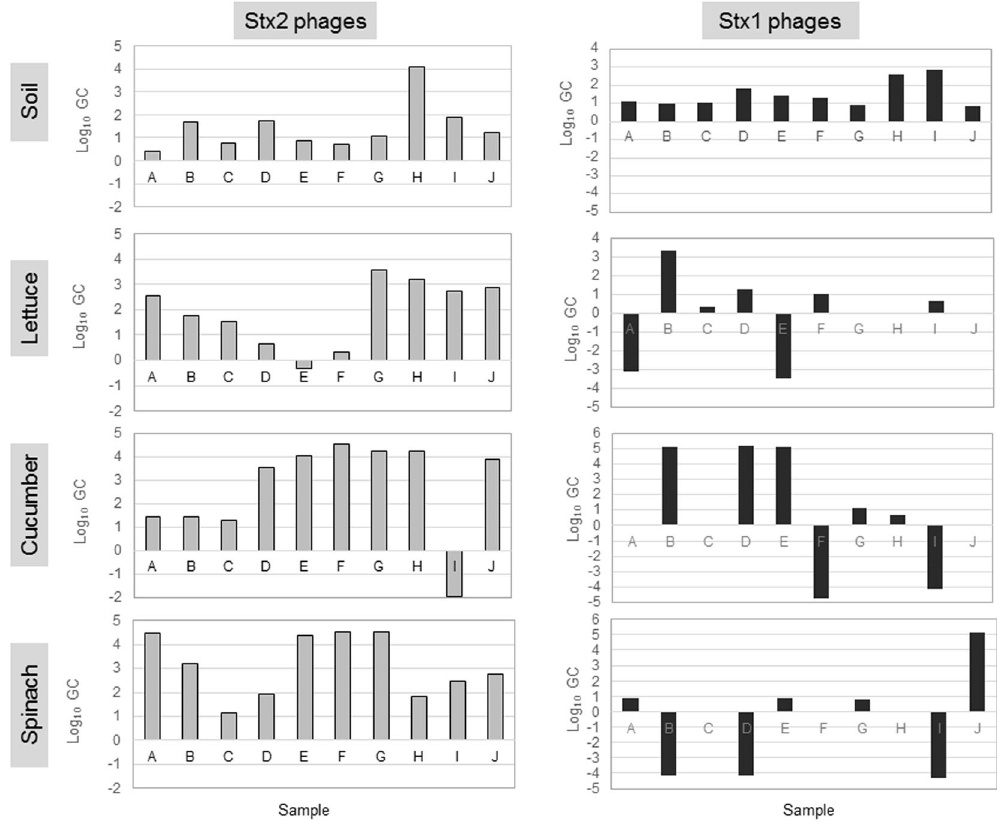
Figure 1. Difference in log 10 GC units of Stx1 and Stx2 phages extracted from matrices after propagation in E . coli WG5 strain. A positive difference indicates phages were infective and able to